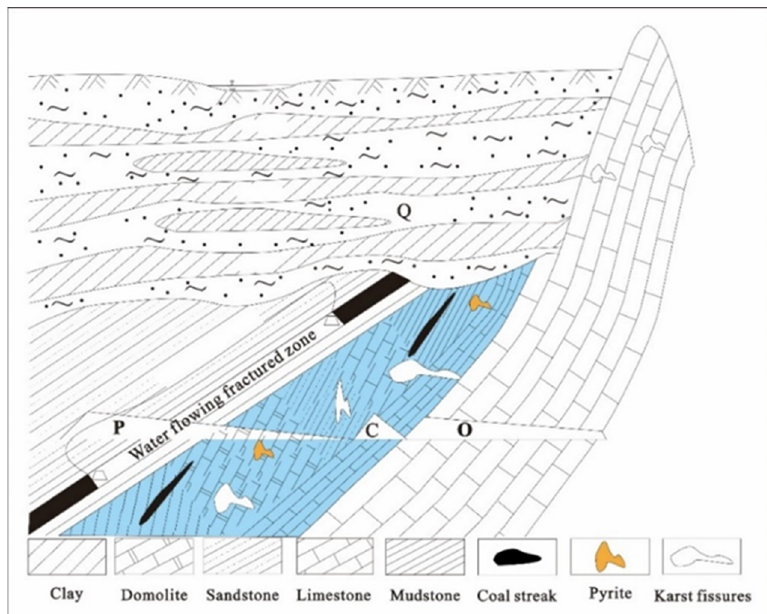
Figure 3. Hydrogeological profile of the study